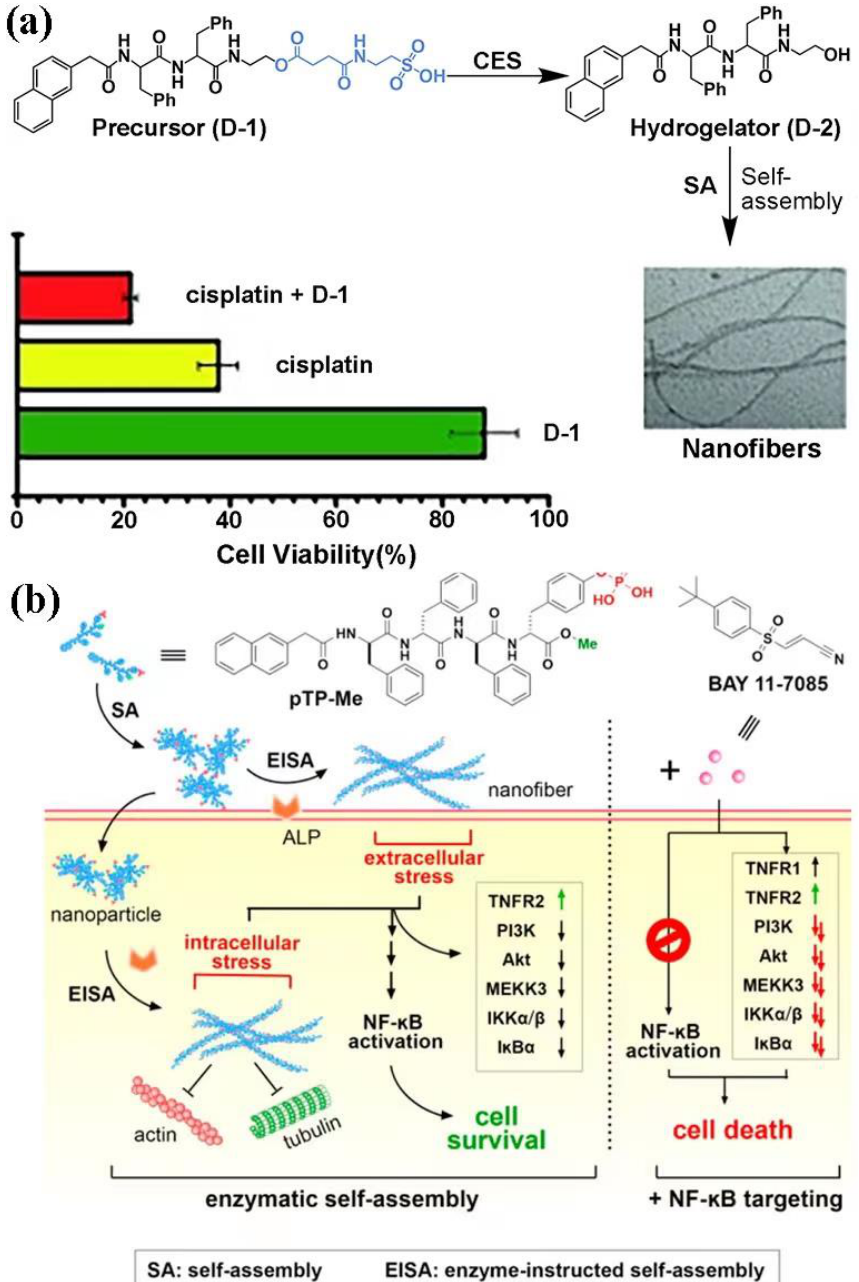
Figure 6. IEISAP for anticancer combination therapy. ( a ) Chemical structure of the precursor D-1 and its enzymatic transformation into nanofibers. The D-1 molecules themselves were innocuous to cells at optimal concentrations, but they could double or triple the activity of cisplatin toward drug-resistant ovarian cancer cells. Reprinted/adapted with permission from [117]. Copyright 2015, John Wiley & Sons, Inc. ( b ) Scheme showing the enzymatic self-assembly of pTP-Me, which induces cellular stress to activate NF- κB signaling for cell survival, as well as the combination of IEISAP and NF- κB targeting for effectively killing cancer cells. Reprinted/adapted with permission from [97]. Copyright 2018, American Chemical Society.